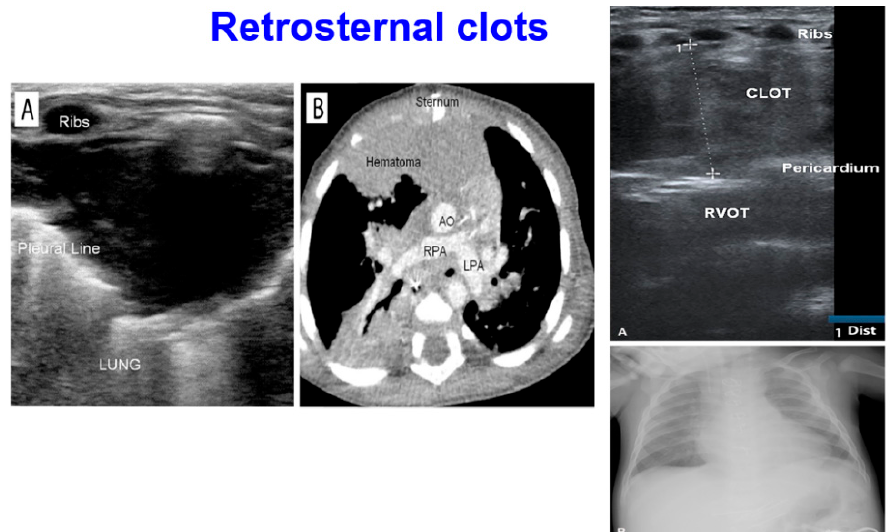
Figure 5. Retrosternal clot. (Left) In ( A ), a retrosternal clot is visualized by LUS and confirmed ( B ) by CT scan. Using LUS, it is possible to appreciate how the clot is interposed among the sternum and the plural line. (Right) A retrosternal clot among the strum and the right ventricular outflow tract (RVOT) is visualized by LUS ( A ). On chest X-ray and enlargement of right mediastinum can be observed (B).